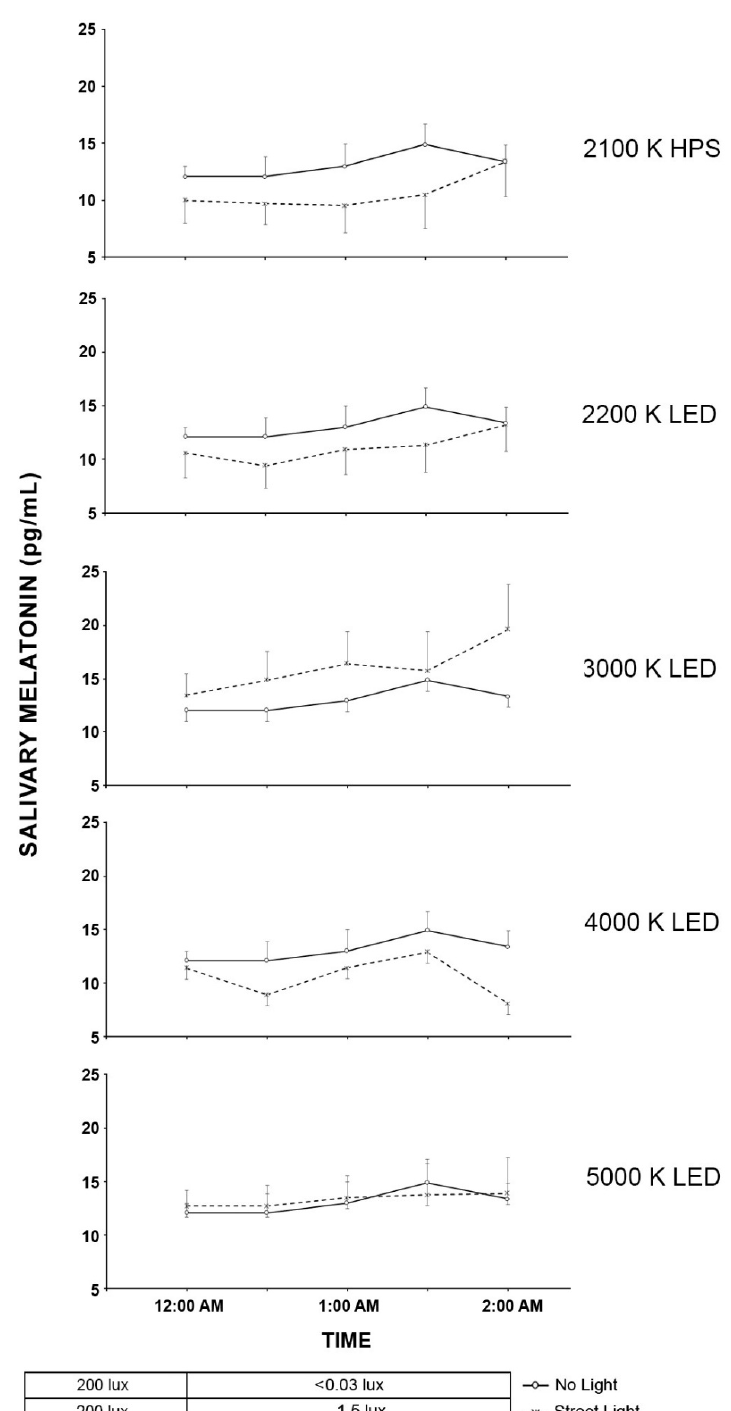
Figure 11. In the five graphs above, roadway light trespass from each of the street lighting conditions is compared to natural light trespass from the same street with no roadway lighting for their effects on salivary melatonin. The O symbols represent the mean salivary melatonin levels during the no electrical light condition (± SEM). The X symbols represent the mean salivary melatonin levels during exposure to roadway lighting (+ SEM). The 1.5-lx illuminance value (0.22–0.86 melanopic EDI) for all roadway lighting conditions was based on the maximum allowable light trespass identified in IESNA RP-18-14